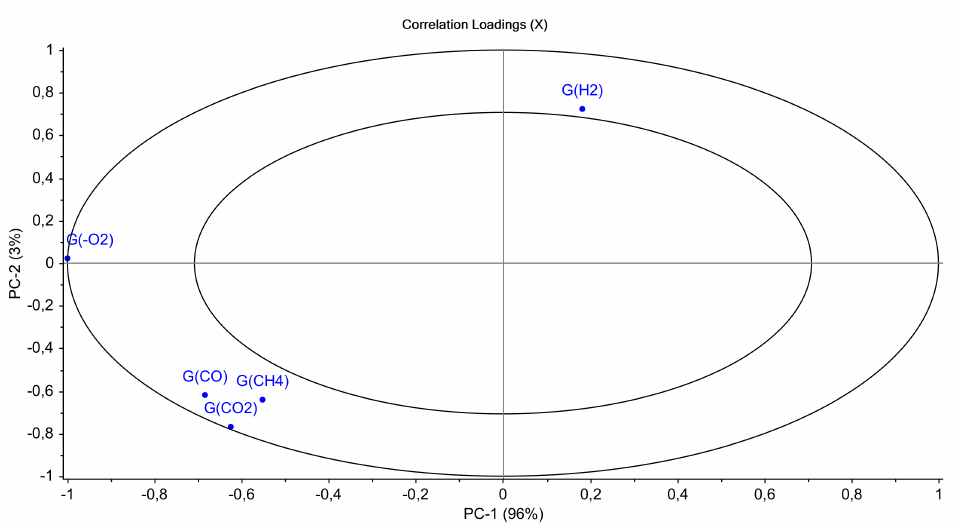
Figure 16. PCA loading for PC1 and PC2 (all